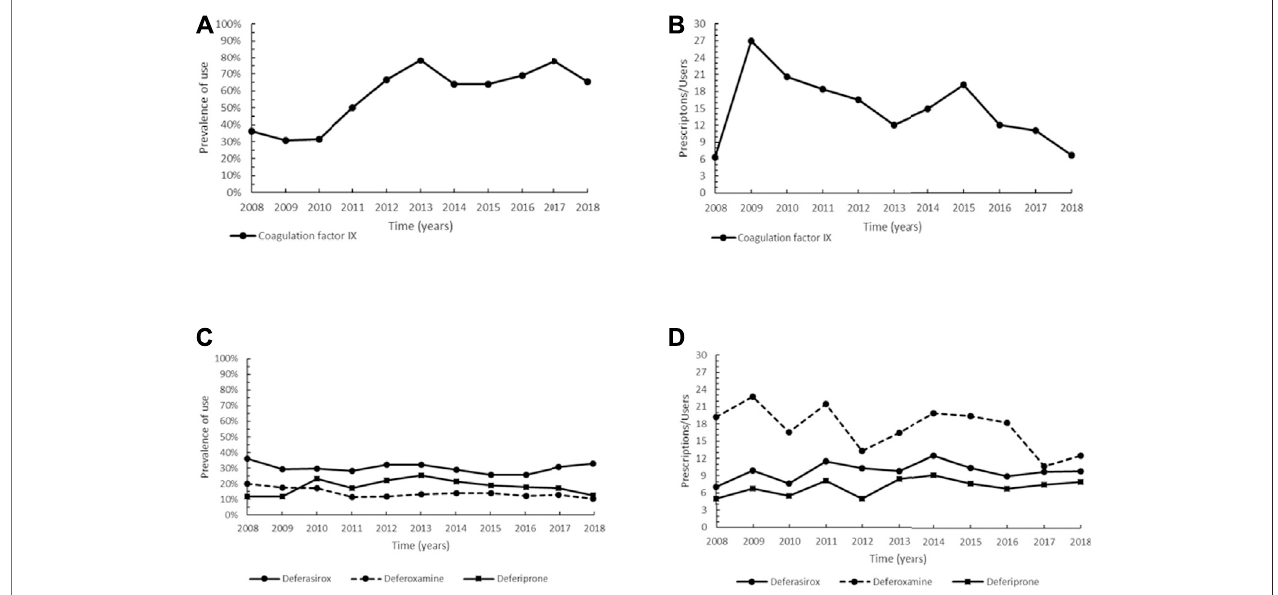
FIGURE 1 | Trend of prevalence (graphs (A,C) ) and intensity of use (graphs (B,D) ) of the coagulation factor IX indicated for hemophilia B and of the orphan drug deferasirox and deferoxamine and deferiprone indicated for β -thalassemia Prevalence of use: ratio between the number of cases with at least one prescription and the number of prevalent cases at the beginning of each year. Prescription/users: ratio between the number of prescriptions of each medication for the total number of patients with at least one dispensing per year.